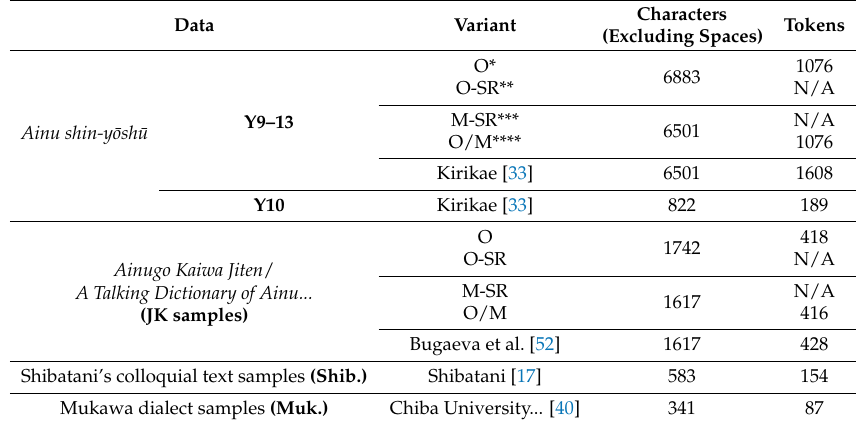
Table 8. Statistics of the samples used for